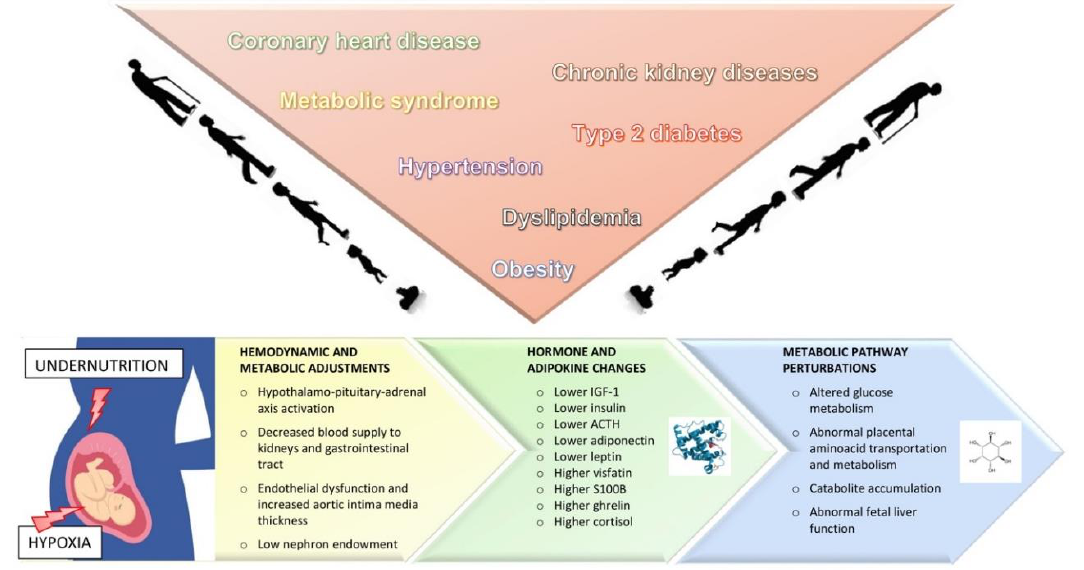
Figure 1. Summary of current knowledge on the short- and long-term consequences of intrauterine growth restriction. The fetus’ prenatal exposure to undernutrition and hypoxia induce hemodynamic and metabolic adjustments, as well as changes in hormones and adipokines. IGF-1: Insuline-like growth factor; ACTH: adrenocorticotropic hormone.